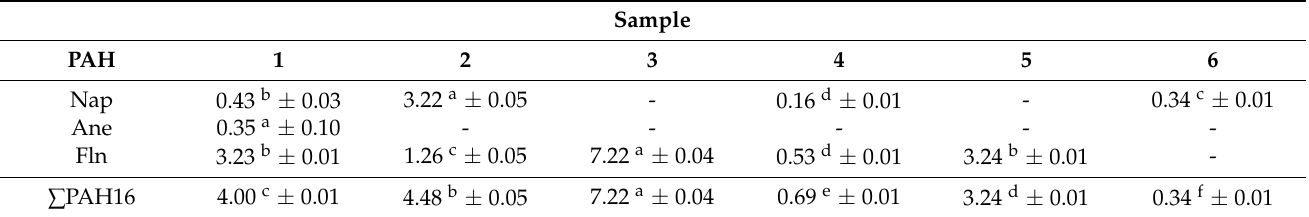
Table 2. PAH content ( µ g/kg) in different popcorn corn varieties in year 2020. Sample